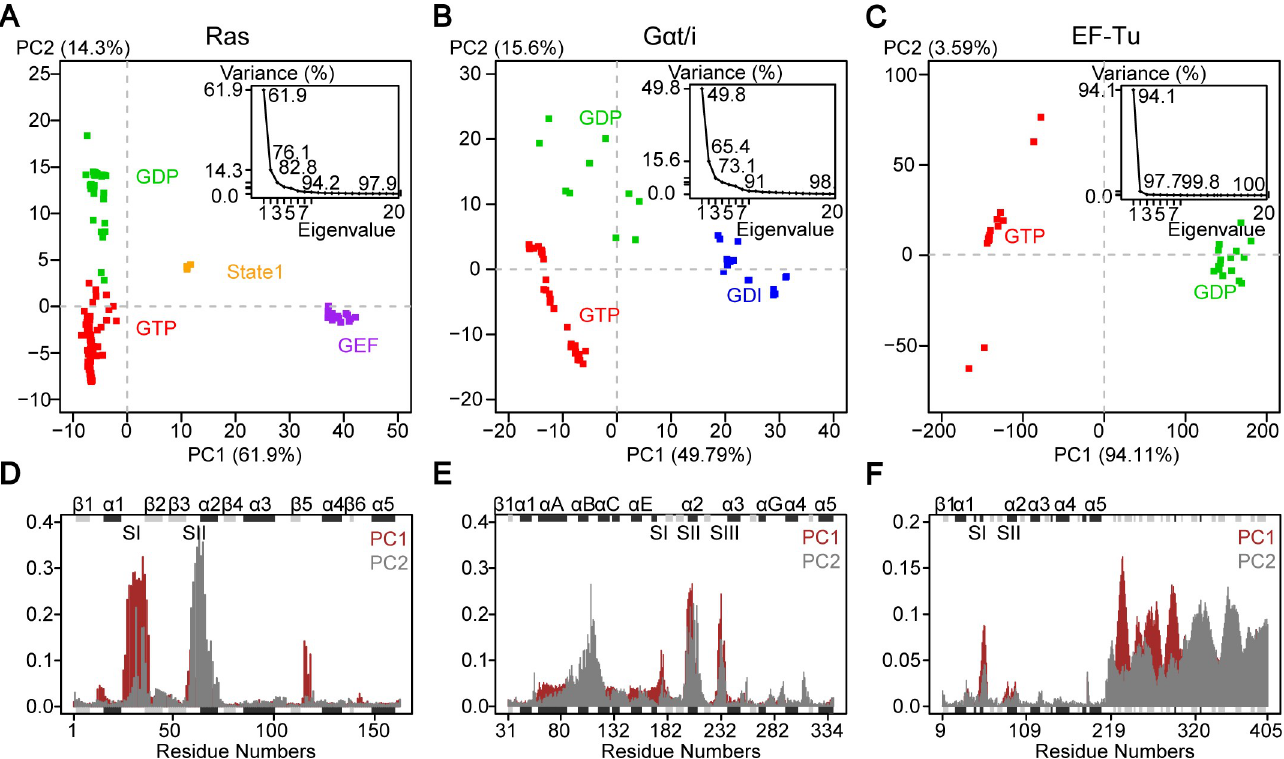
Fig 2. Principal component analysis of Ras, G α t/i and EF-Tu crystallographic structures reveals distinct nucleotide-associated conformations. ( A-C ) Projection of 121 Ras ( A ), 53 G α t/i ( B ) and 23 EF-Tu ( C ) PDB structures (represented as squares; see also S1–S3 Tables ) onto the first two PCs reveals different conformational clusters corresponding to GTP (red), GDP (green), GEF (purple) and GDI (blue) bound states. A distinct cluster of GTP-bound structures in Ras corresponds to the “State 1” state (orange). The inserted figures show that the first two PCs capture 76.1%, 65.4% and 97.7% of the total structural variances in Ras, G α t/i and EF-Tu, respectively. ( D-F ) The contributions of each residue to PC1 (brown) and PC2 (grey) show that the switch regions mainly correspond to the accumulated structural differences in Ras ( D ) and G α t/i ( E ). In addition to switch regions, Domain 2 and Domain 3 also contribute to the structure differences in EF-Tu ( F ). The marginal black and grey rectangles with labels on top of them represent the location of alpha-helix and beta-strand secondary structures.